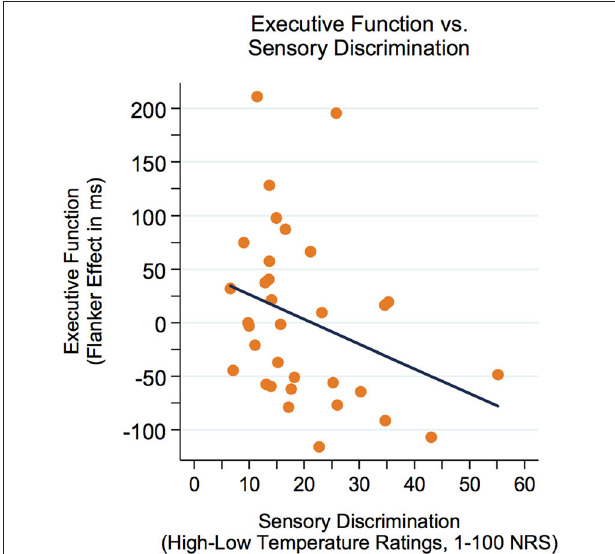
FIGURE 3 | The Flanker effect was modestly yet not significantly correlated with sensory discrimination ( r = − 0.32, p = 0.073). Better executive function = lower Flanker effect. NRS, numeric response scale.